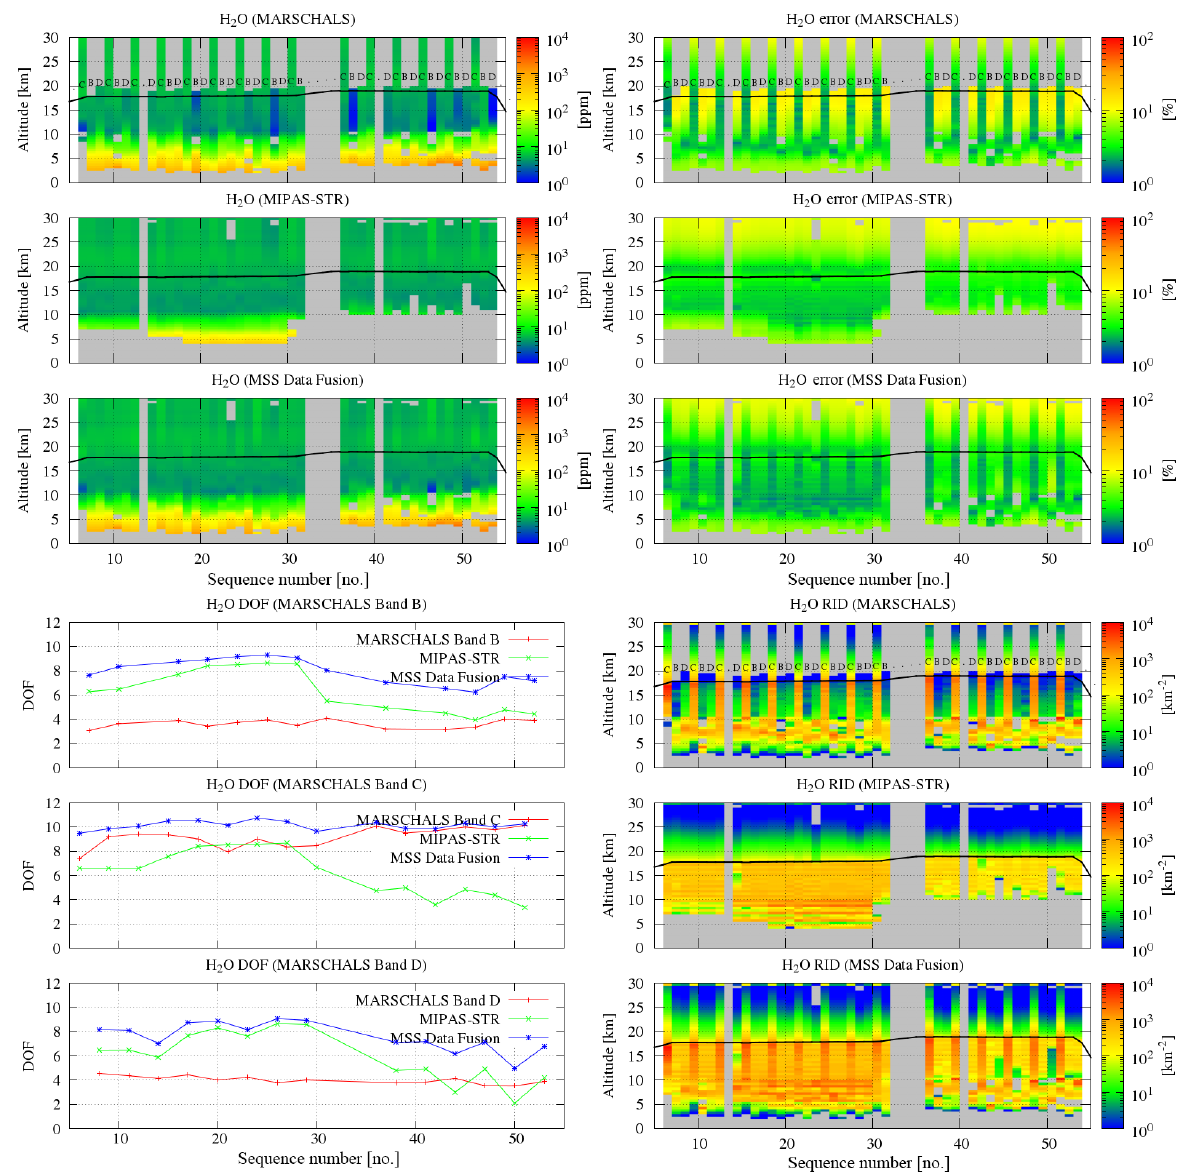
Figure 7. H 2 O retrieved results obtained from MSS individual analysis and MSS data fusion of MARSCHALS and MIPAS-STR limb sounding observations: vertical profiles (top left panel), total relative error profiles (top right panel), number of DOF (bottom left panel) and RID profiles (bottom right